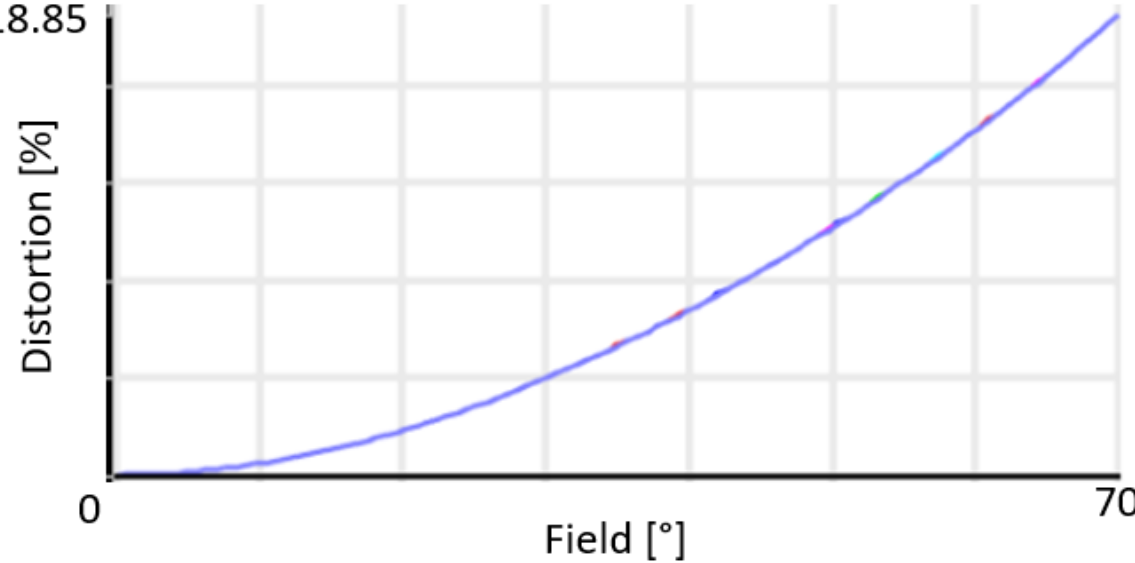
Figure 5. Barrel distortion is the main aberration present in the optical design, due to the wide field of view. Distortion is maximal at 70°, where it equals 18.85%. In this graph, the vertical axis expresses the distortion in %, and the horizontal axis gives the half FOV in